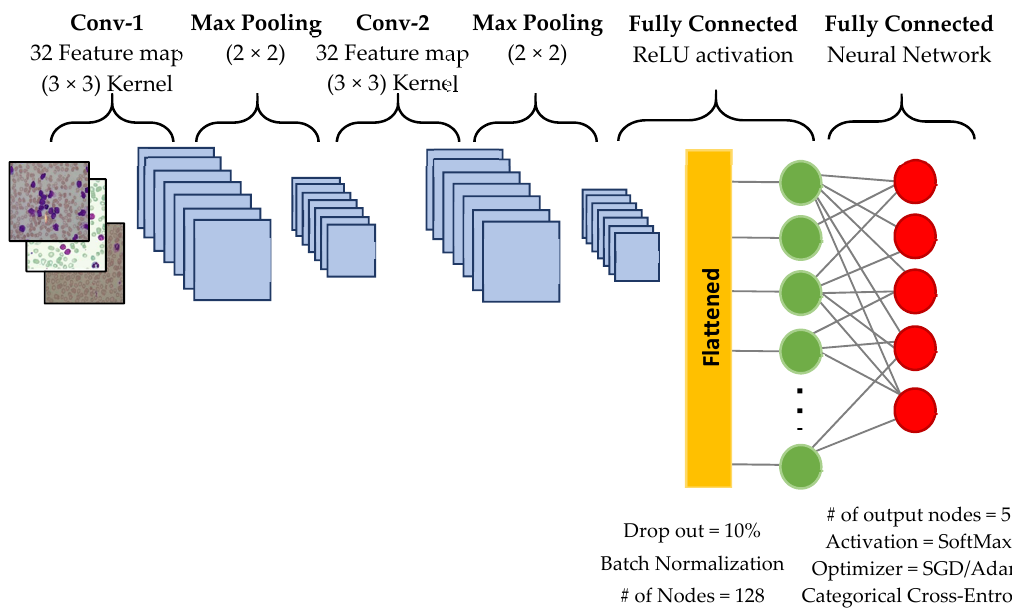
Figure 3. The proposed convolutional neural network (CNN) architecture.